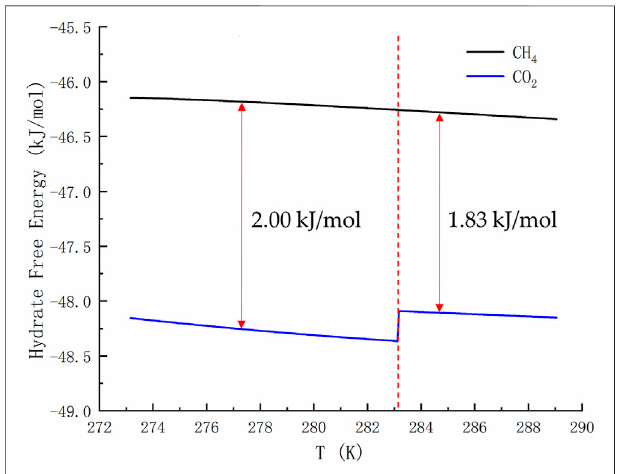
FIGURE 3 | Free energy of pure CH 4 hydrate and CO 2 hydrate. The temperature range shown in the curve is 273.17 – 289.05